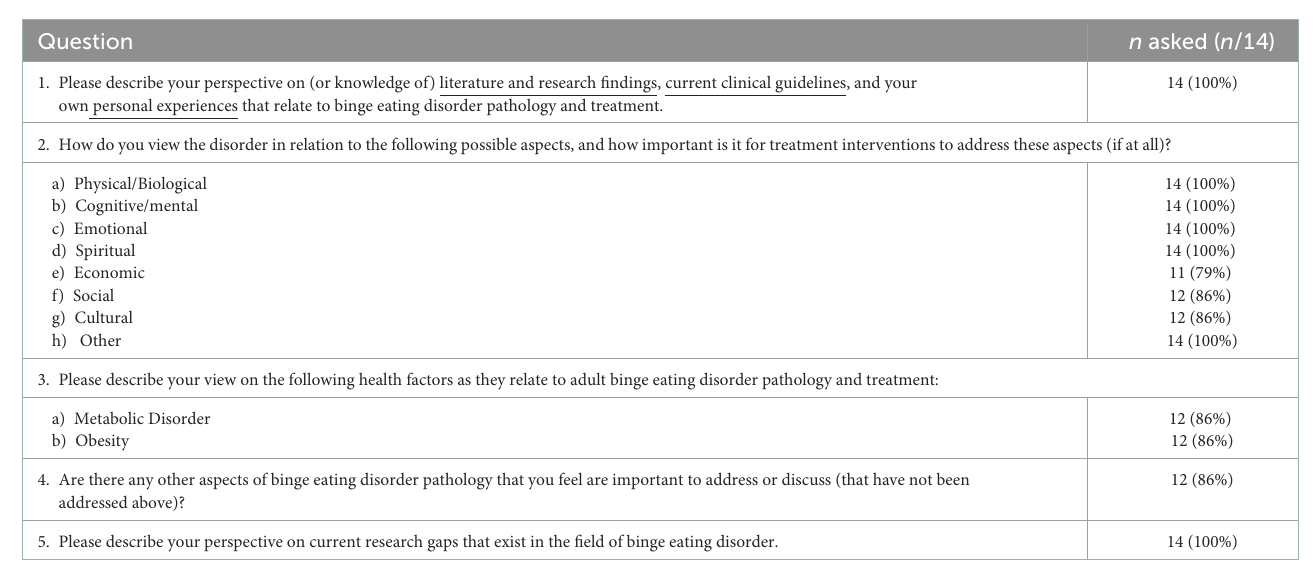
TABLE 2 Interview questions pertaining to clinical factors relevant to adult binge eating disorder